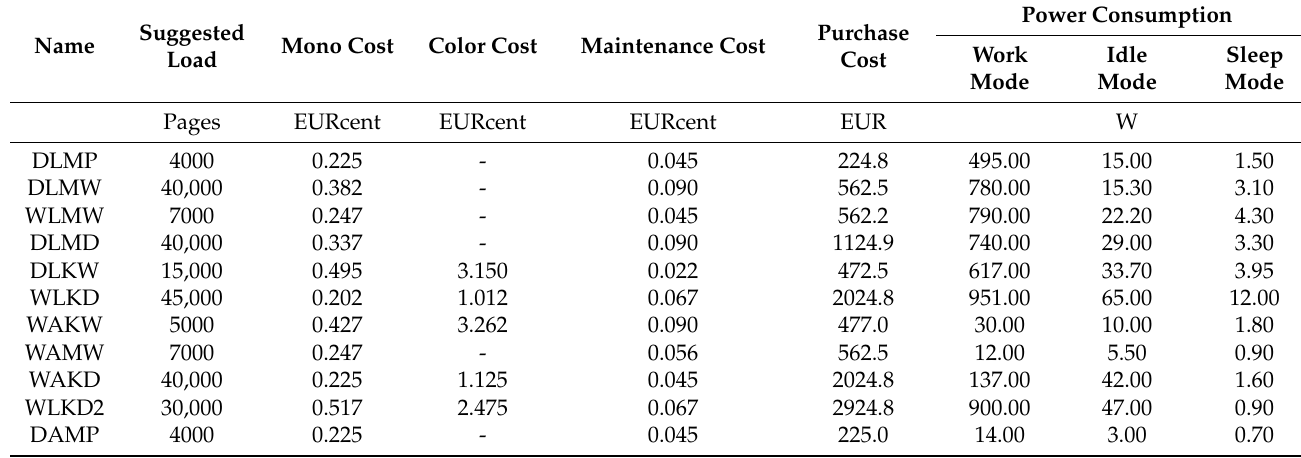
Table 4. Techno-economic parameters of the printing devices used in the case study.